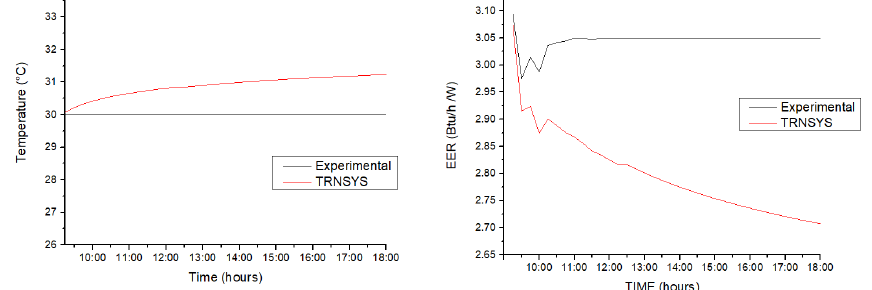
Figure 12. Comparison between simulated and experimental results of temperature and EER at a flow rate of 3GPM.